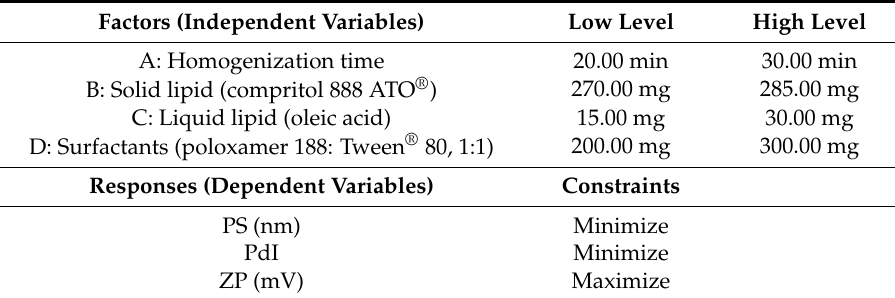
Table 1. Description of 2 4 full factorial